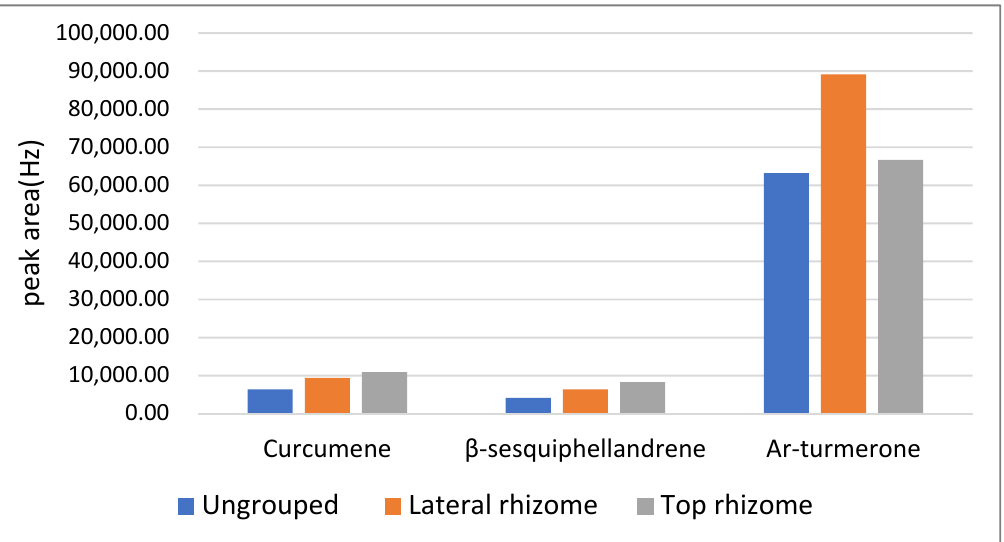
Figure 7. Comparative map of curcumene, β -sesquiphellandrene and ar-turmerone in different parts of turmeric in Yunan by GC-SAW.